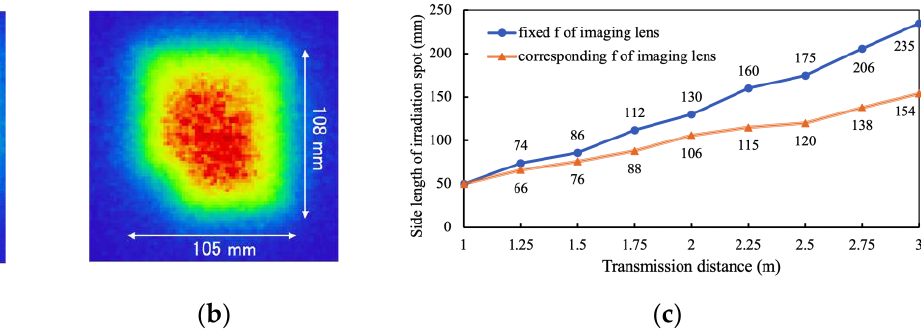
Figure 12. Simulated irradiation spot in long-distance transmission: ( a ) f = 1 m imaging lens at 2 m; ( b ) f = 2 m imaging lens at 2 m; ( c ) simulated irradiation spot side length with fixed and corresponding focal length of imaging lens. Side length is measured from the range where the light intensity is 20% or more of the peak intensity.